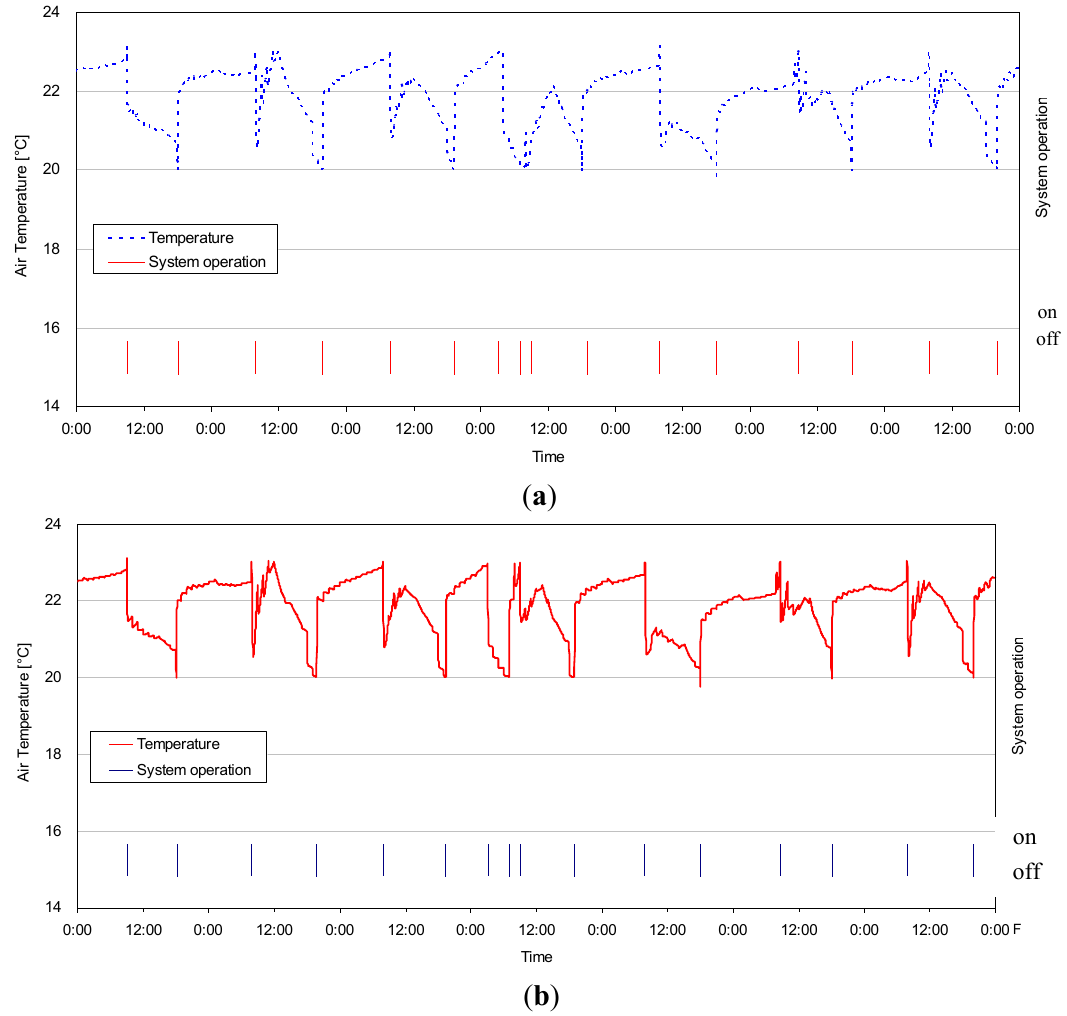
Figure 8. Indoor temperature and operation of heating system (Single Skin